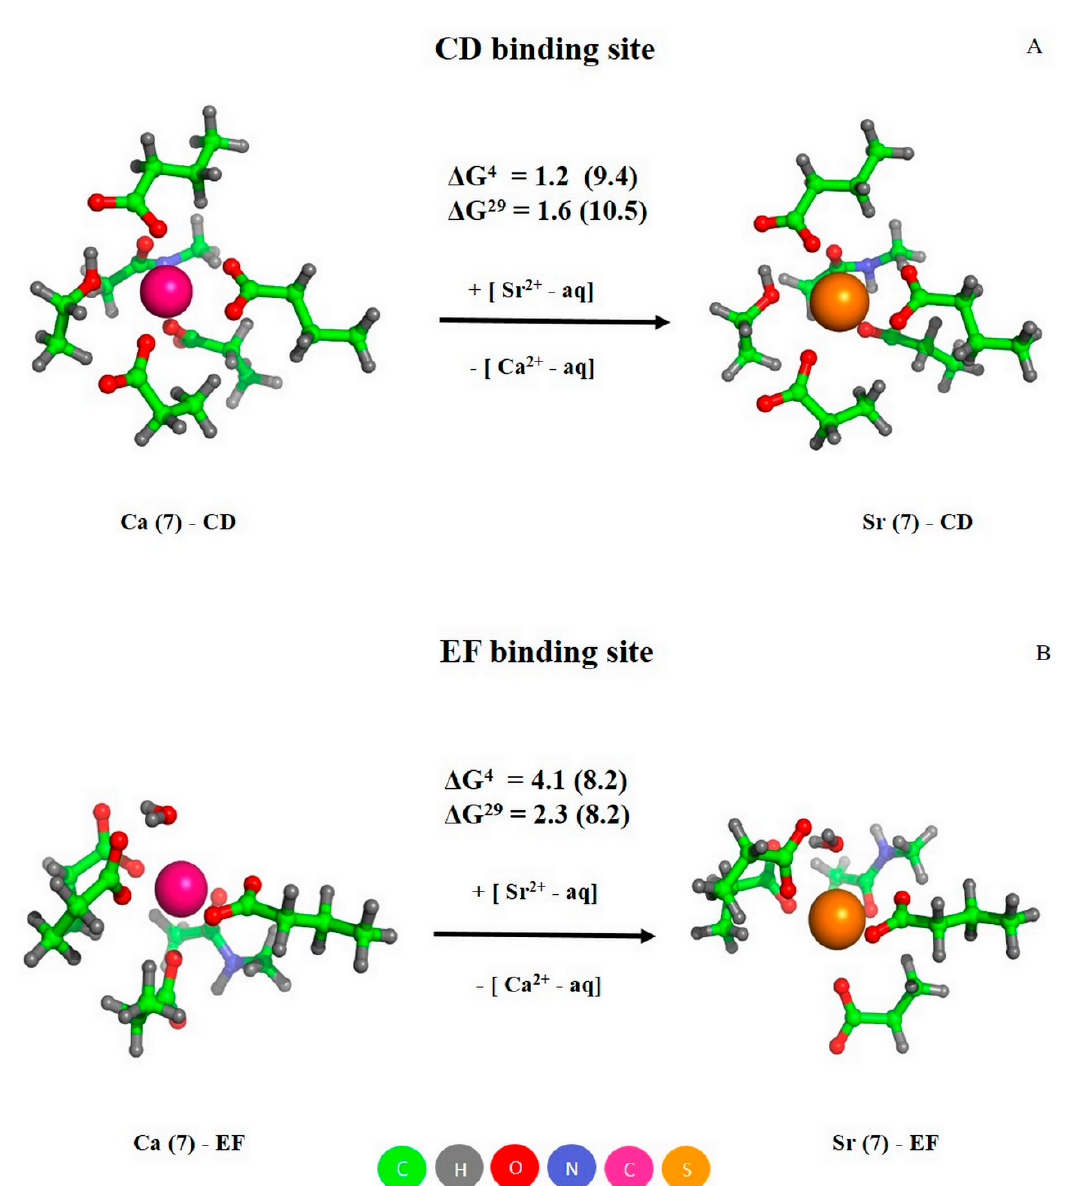
Figure 8. The optimized structures of Ca 2+ /Sr 2+ -loaded CD ( A ) and EF ( B ) sites of PA, and free energies of metal exchange (in kcal/mol). The free energies evaluated for ‘rigid’ Ca 2+ -binding sites are given in parentheses. Metal coordination number is indicated in parentheses in the complex name.